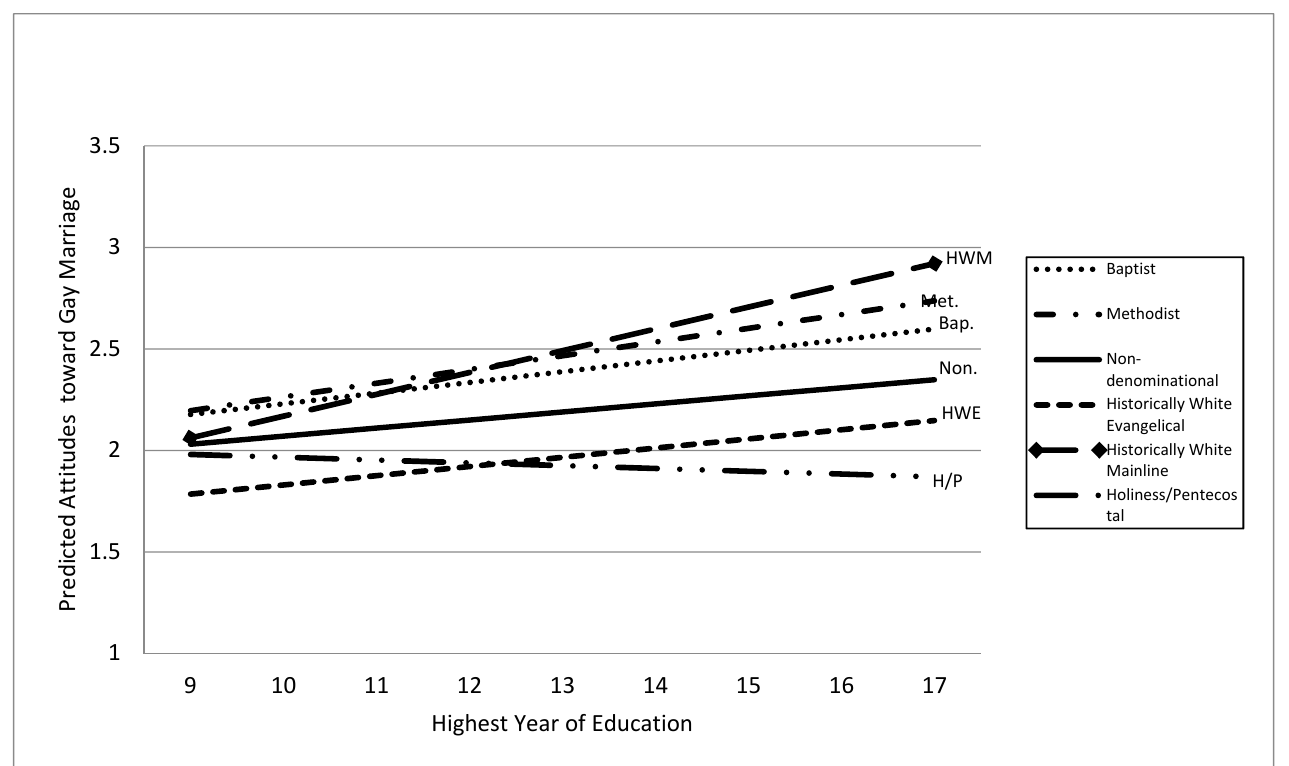
Figure A5. Black Protestant views on gay marriage by religion and education, Pew 2014 Religious Landscape Survey.